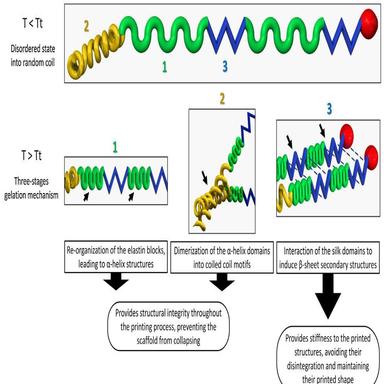
Graphical scheme of the peptide blocks that constitute the novel designed ELR ink and its block molecular assembling leading to stabilisation.